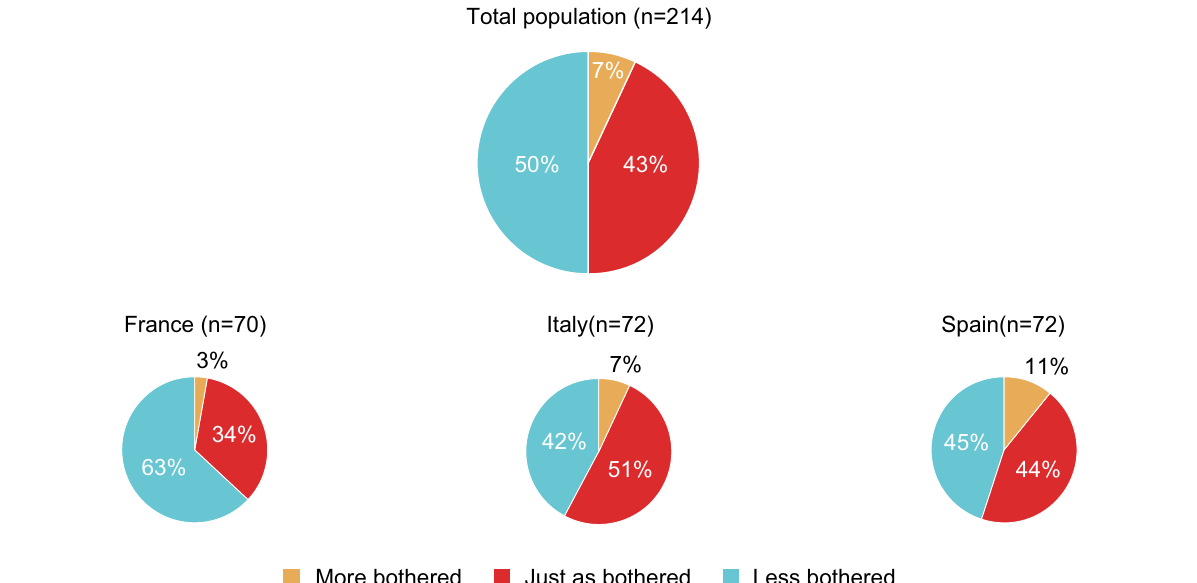
Fig. 7 Overall change in the disease burden of HDM allergy symptoms during the study period (according to the final questionnaire) for the study population as a whole and in each